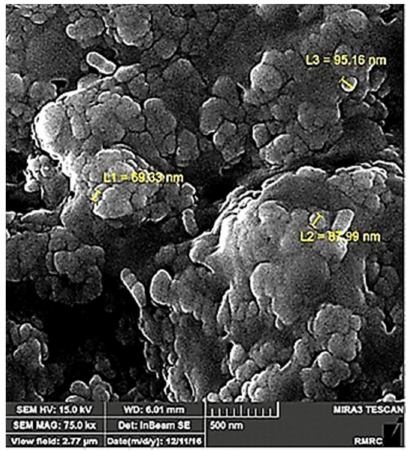
Figure 8. The FESEM image from SiO 2 Nanoparticle synthesized, Reprinted by permission from Springer Nature: International Journal of Environmental Science and Technology, [37] copyright